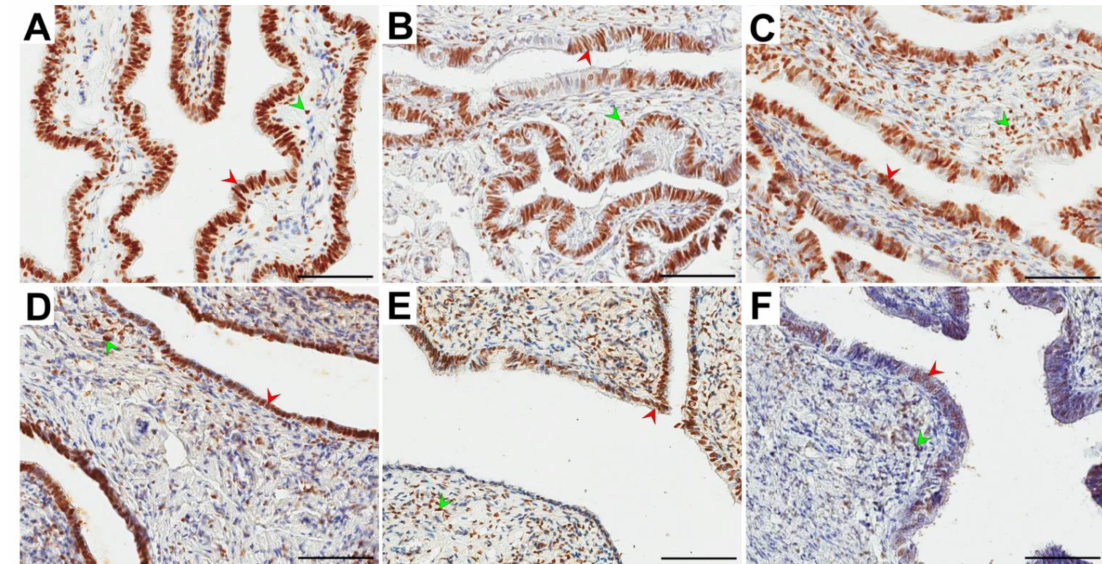
Figure 2. Representative light micrographs of the nuclear immunolocalization (brown color) of estrogen receptor α (ER α ) in the glandular epithelium (red arrowheads) and the stroma (green arrowheads) of the ampulla ( A – C ) and isthmus ( D – F ) of the fallopian tubes in postmenopausal women for whom 1–5 years ( A , D ), 6–10 years ( B , E ) and ≥ 11 years ( C , F ) had elapsed between the last menstrual period and surgery. Note that in the glandular epithelium, immunonegative ER α cells in the form of clusters were usually observed. Scale bar—50 µ m. Table 2. The percentage of ER α -positive cells in the glandular epithelium and the stroma of